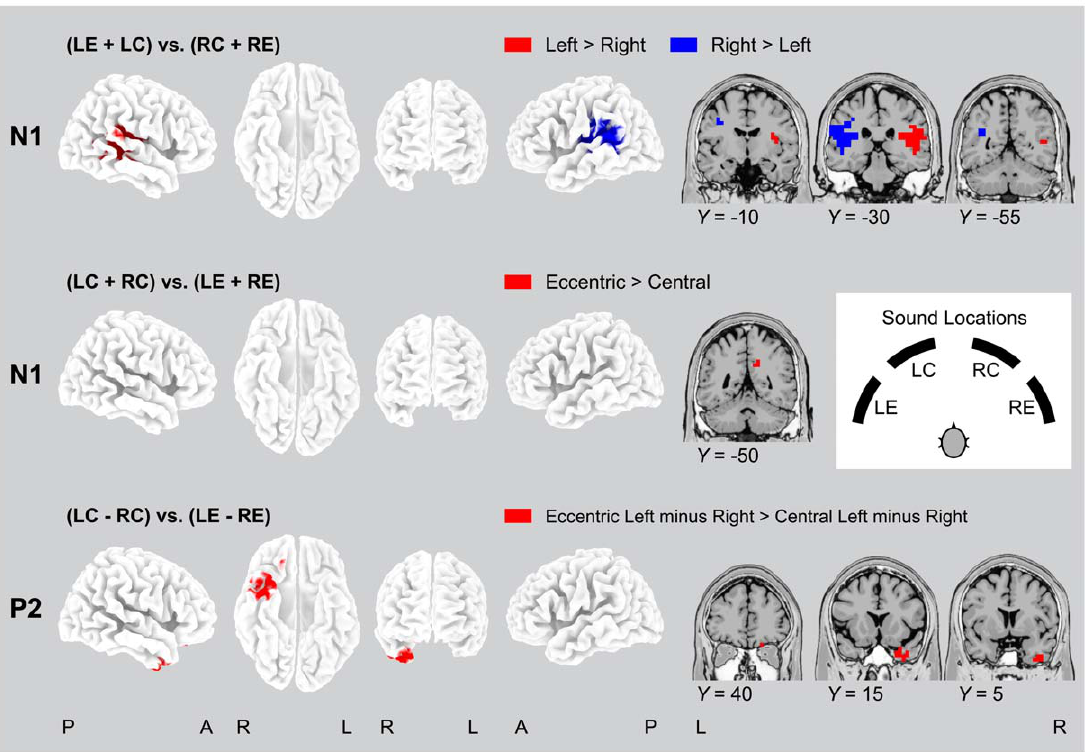
Figure 5. Activations of cortical regions as revealed by different contrasts. The contrasts of left vs. right [(LE + LC) vs. (RC + RE)] and central vs. eccentric sound locations [(LC + RC) vs. (LE + RE)] indicated significant activations exclusively at the N1 component of the responses to different sound locations. The more complex interaction of the difference of left and right central locations vs. the difference of left and right eccentric locations [(LC 2 RC) vs. (LE 2 RE)] was significant only at the P2. Contrasts are mapped onto a standard 3-D brain template and coronal slices (MNI-templates as in Figs. 2, 4). Data are as given in Table 3. LE, left eccentric; LC, left central; RC, right central; RE, right eccentric. No significant activations were found for the left vs. right and central vs. eccentric sound locations at the P2, and for the interaction at the